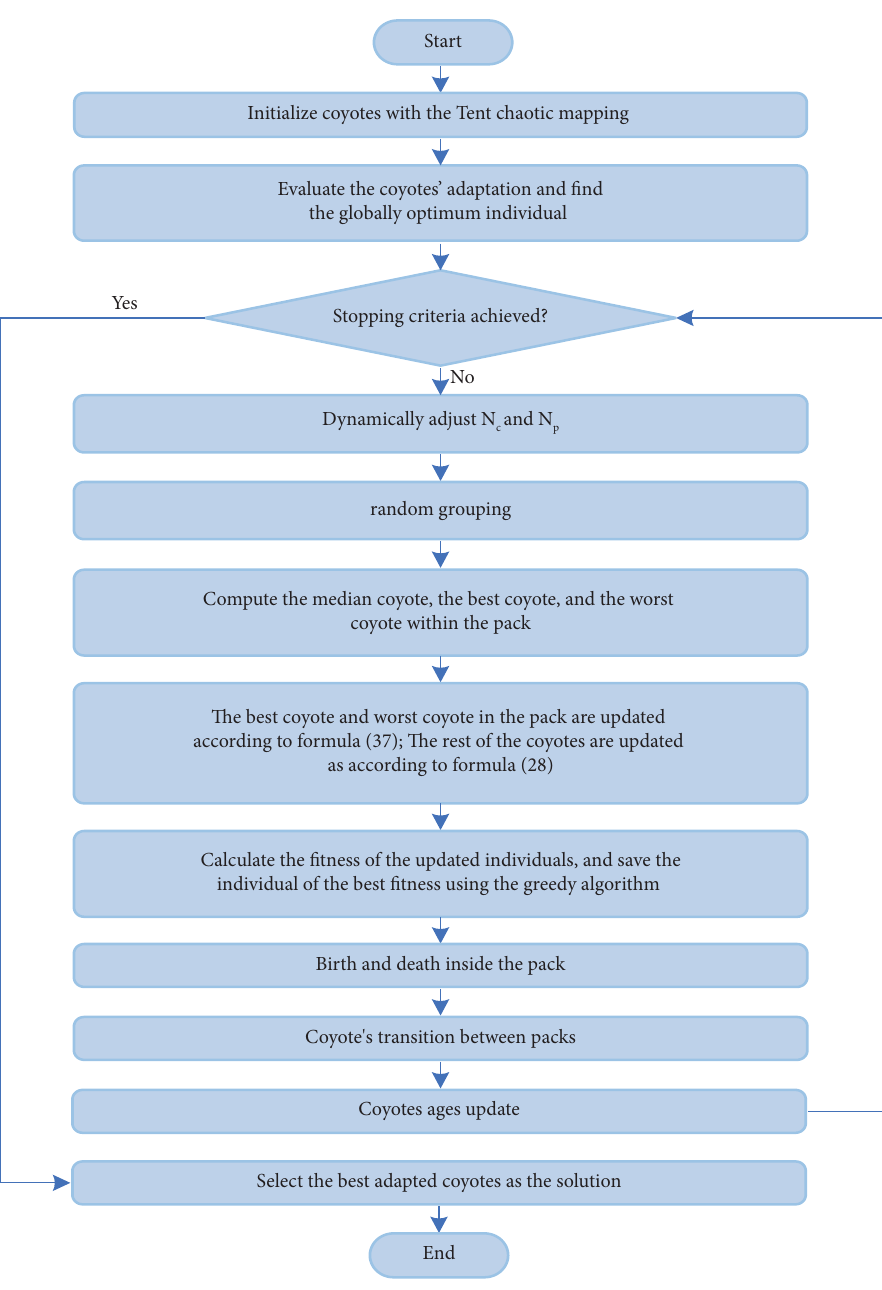
Figure 4: Te fowchart of the BCOA.